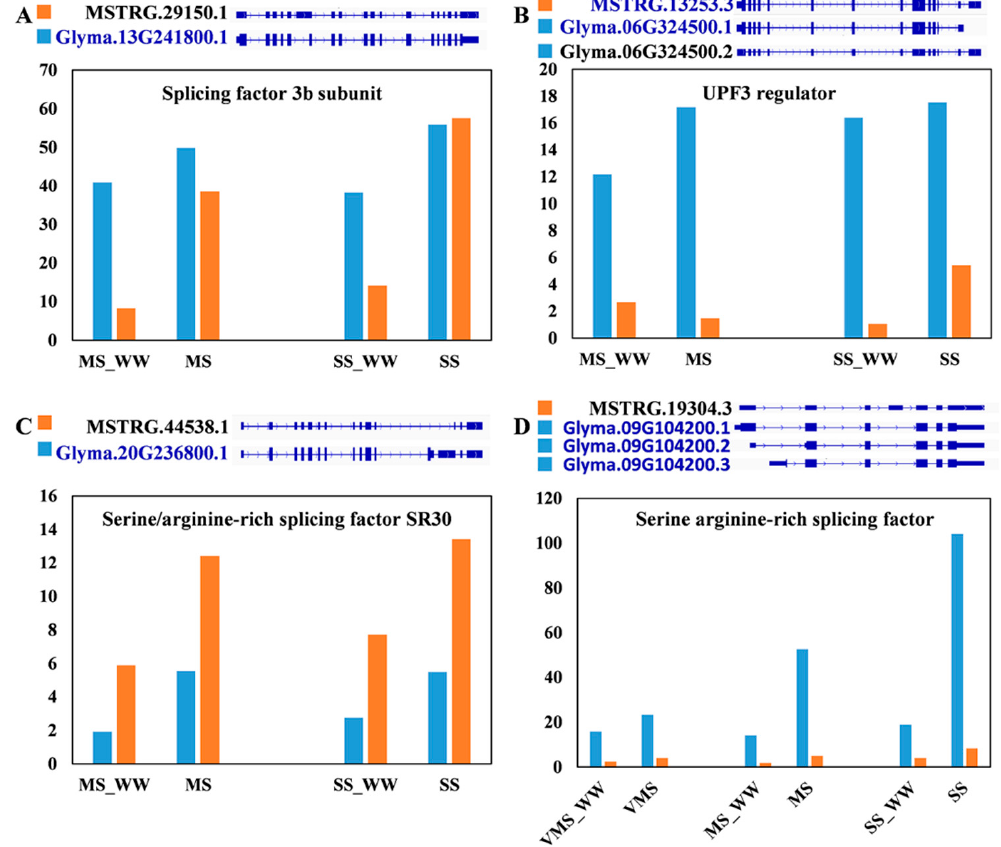
Figure 7. Visualization of representative transcript isoforms of four SPF-related genes to indicate expression changes under various drought stresses. MSTRG indicates the novel transcripts in this study. ( A ) Splicing factor 3b subunit (Glyma.13G241800) switched between MSTRG.29150.1 and